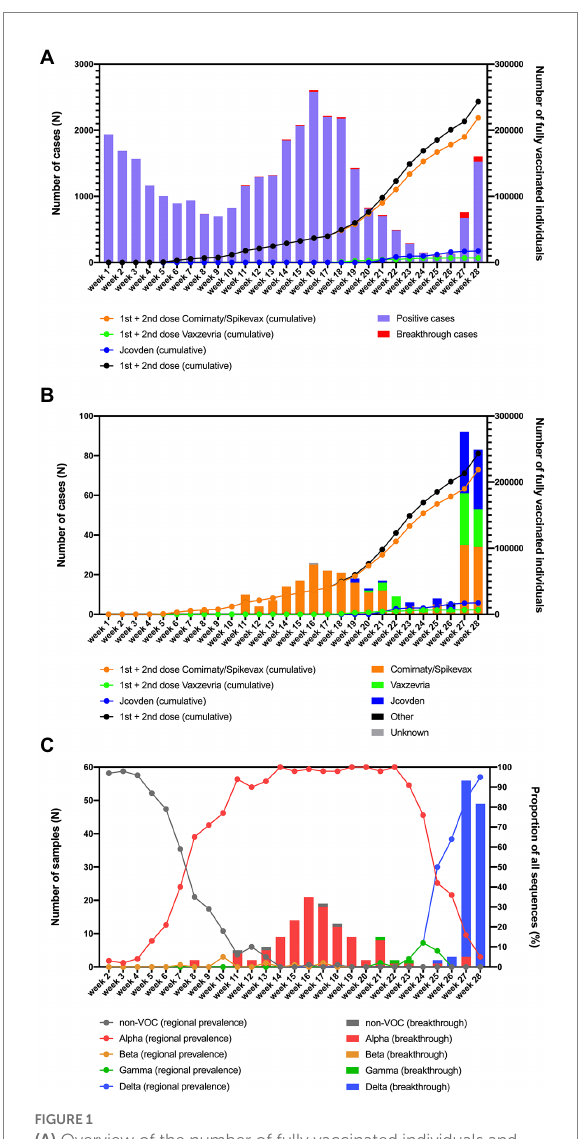
FIGURE 1 (A) Overview of the number of fully vaccinated individuals and breakthrough infections in function of time in the region of South Limburg. (B) Breakthrough infections per vaccine in function of time. (C) Evolution of the prevalence of Non-VOC and VOC lineages in the community (lines) as well as the distribution of variants causing breakthrough infections (bars) in function of time in the region of South Limburg. The numbers represented by bars are plotted on the left y-axis, while the numbers represented by dots/lines are plotted on the right y